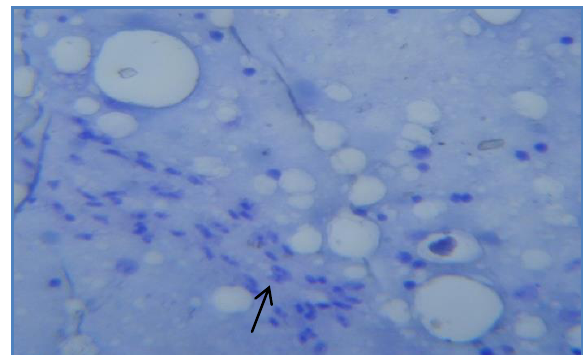
Figure, 3: Sister chromatid exchange in chick embryo cells after 20 µg Levofloxacin in-ovo inoculation after 7 days of incubation (Hoechest stain 100x under light microscope)